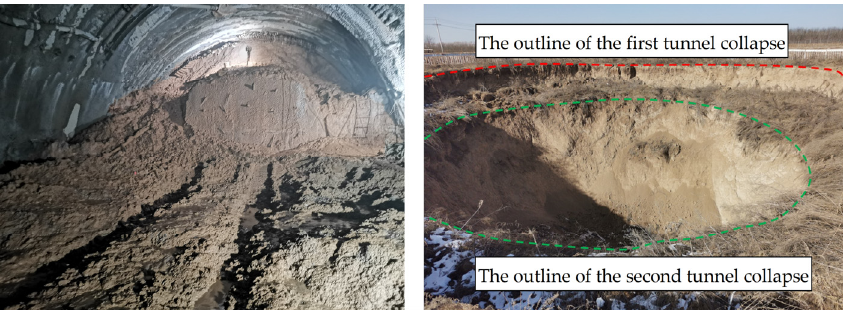
Figure 5. Water inrush and surface collapse of Yulinzi Tunnel.